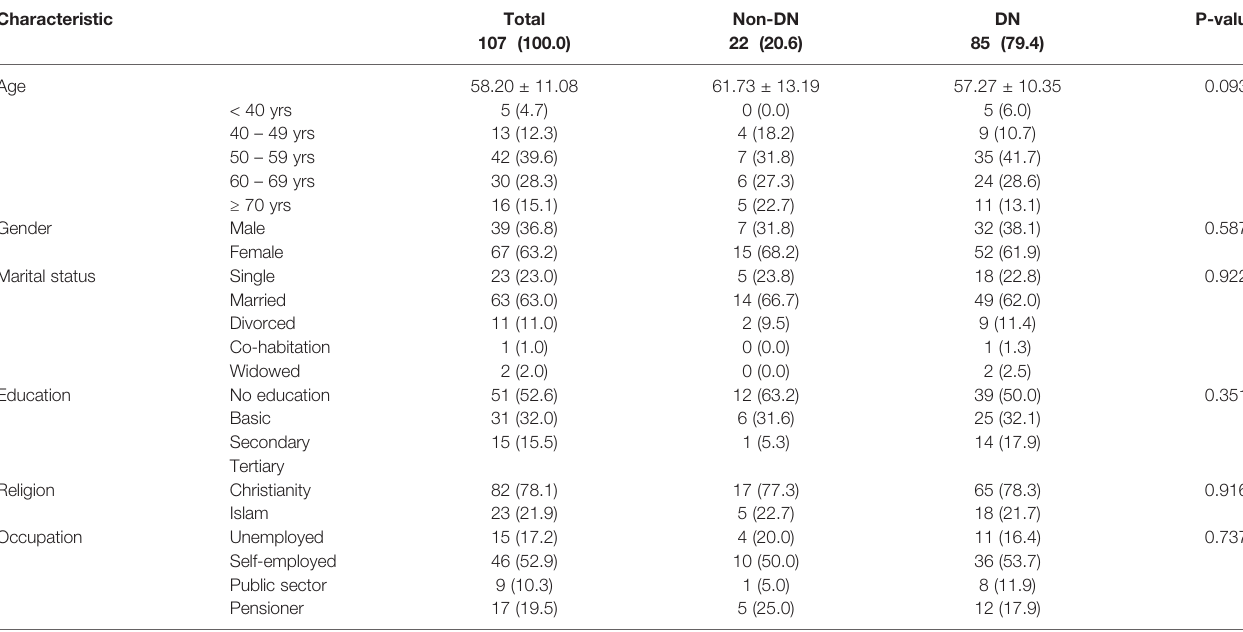
TABLE 1 | Sociodemographic characteristics of the study participants.